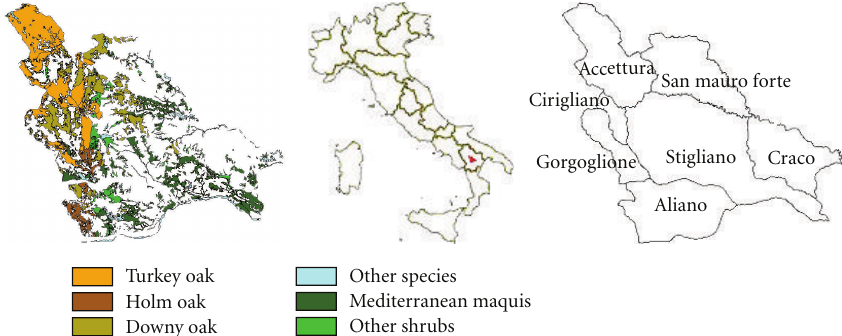
Figure 1: Collina Materana district: forest types (left) and municipalities (right).